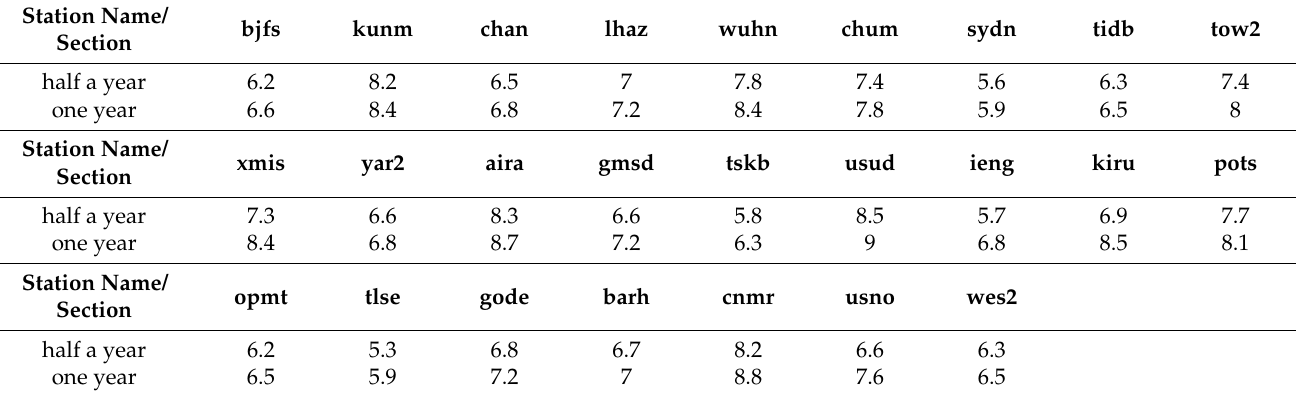
the prediction effect. Table 12. CORS station elevation prediction RMSE accuracy statistics based on GARCH+ nonlinear LS